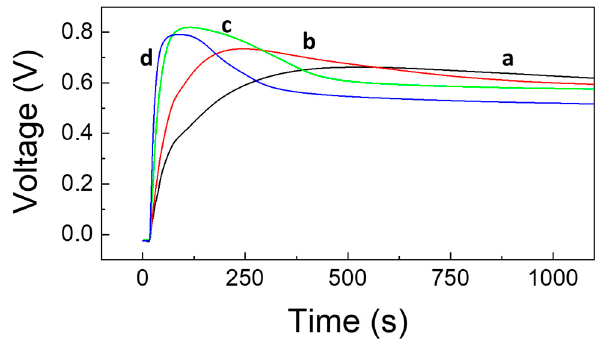
Figure 10. Voltage–charge curves as voltage vs. time, performed by operating with di ff erent per- centages of denatured ethanol in the presence of LDHs and hydrogen peroxide in solution. Curves obtained using: ( a ) 1.92%, ( b ) 3.60%, ( c ) 7.00%, and ( d ) 9.00% in denatured ethanol.